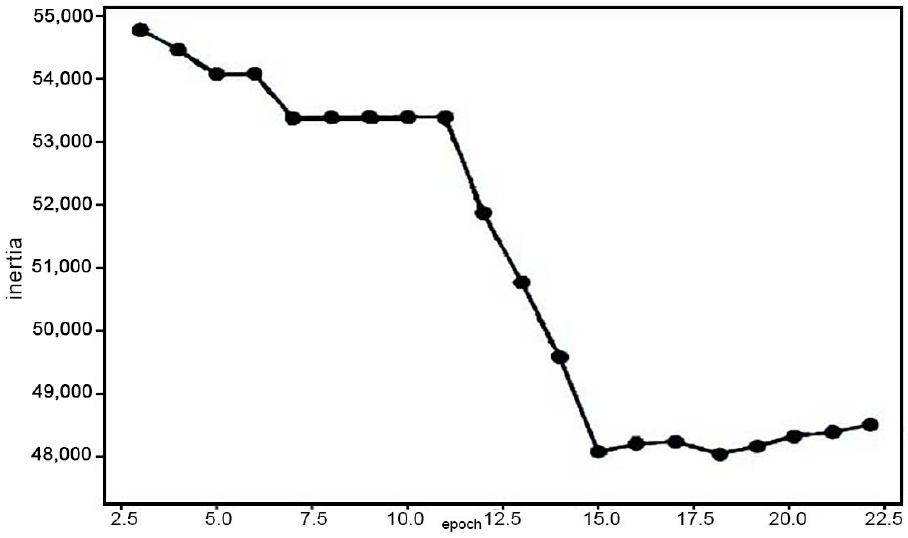
Figure 5. The sum of squared distances corresponding to different cluster numbers.